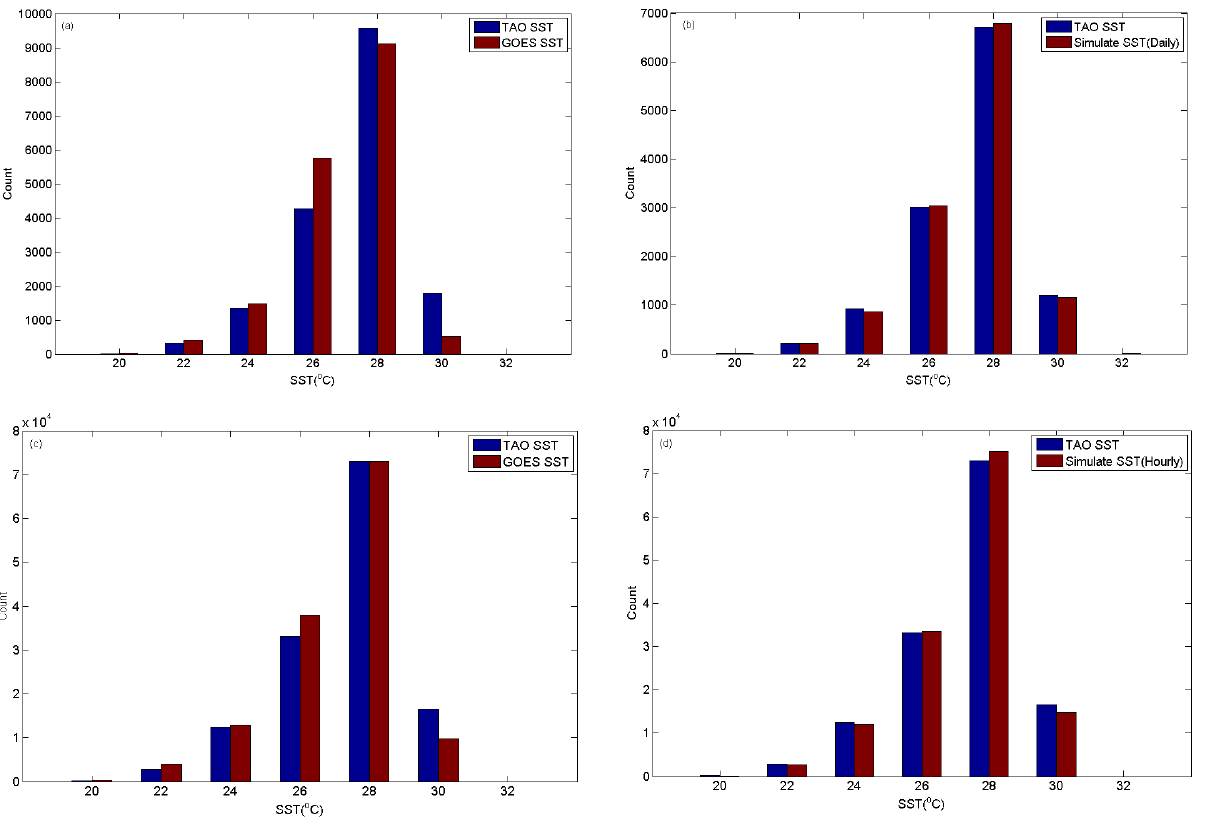
Figure 4. Histogram of original SST and simulated SST. (a) Daily data of GOES SST vs. TAO SST; (b) Daily data of simulated SST vs. TAO SST; (c) Hourly data of GOES SST vs. TAO SST; (d) Hourly data of simulated SST vs. TAO SST.